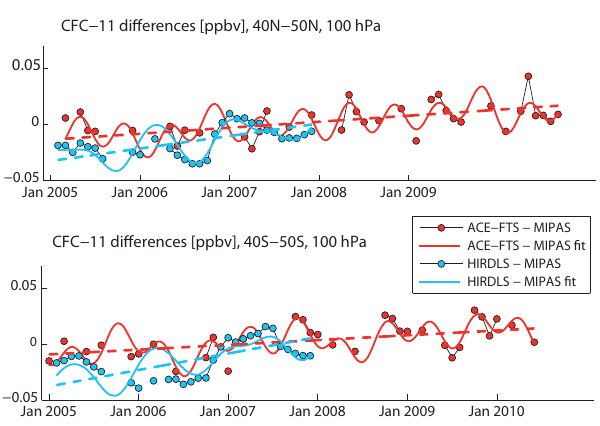
Figure 3. Time series of zonal monthly mean CFC-11 absolute differences between ACE-FTS and MIPAS (black lines, red sym- bols) as well as HIRDLS and MIPAS (black lines, blue symbols) are given for 2005 to 2010 at 40–50 ◦ N and 40–50 ◦ S at 100hPa. Additionally, the calculated fit (solid colored line) and the corre- sponding linear term (dashed colored line) are shown.